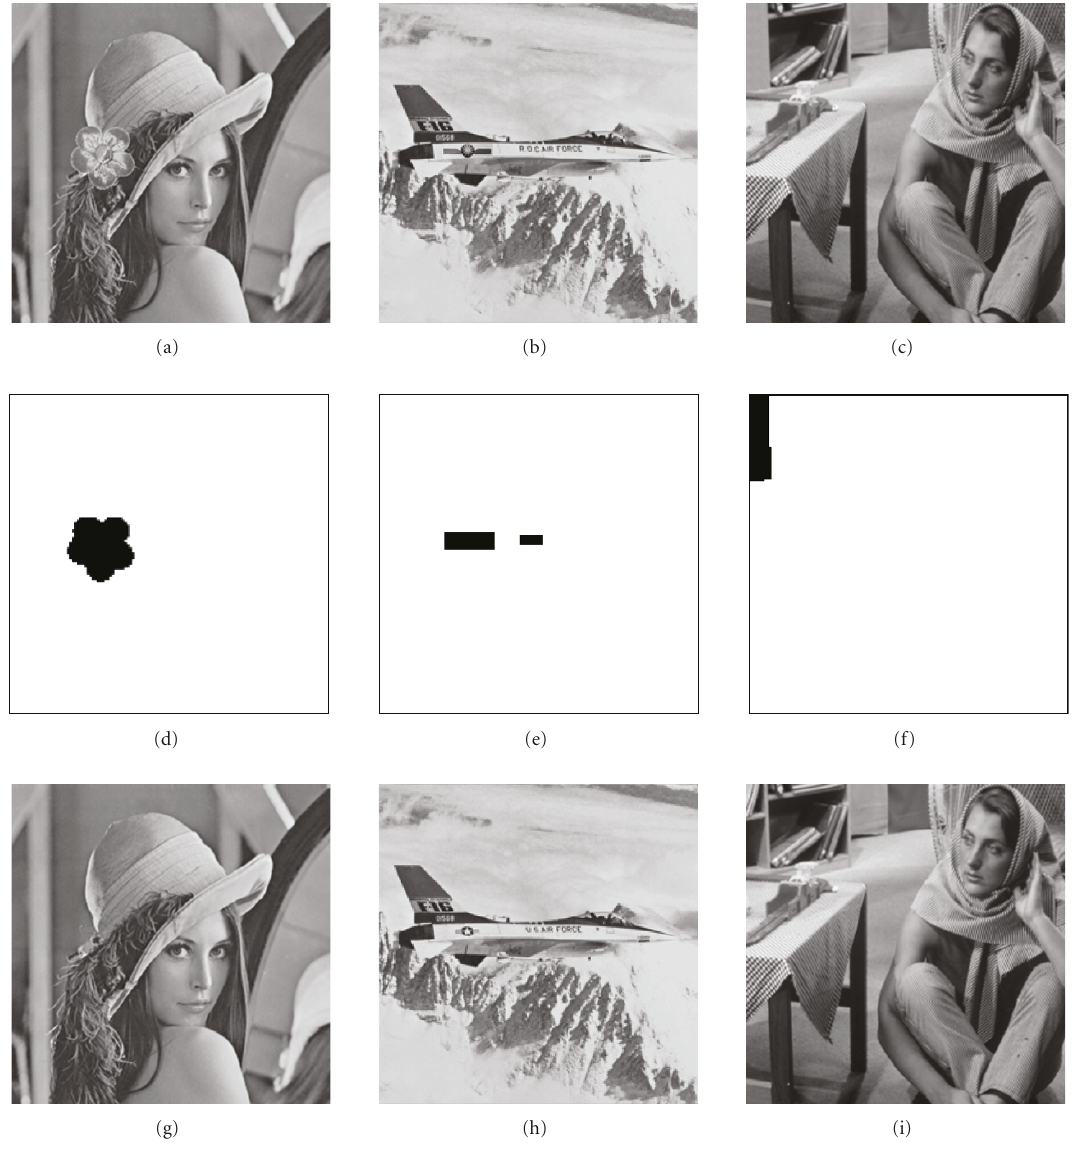
Figure 7: The collage attack experiments: (a) a tampered version of Lena (W) ; (b) a tampered version of Jet (W) ; (c) a tampered version of Barbara (W) , respectively; (g)–(i) the images recovered from (a)–(c), respectively. The PSNR values are 41.58 dB for (g); 42.45 dB for (h); and 43.01 dB for